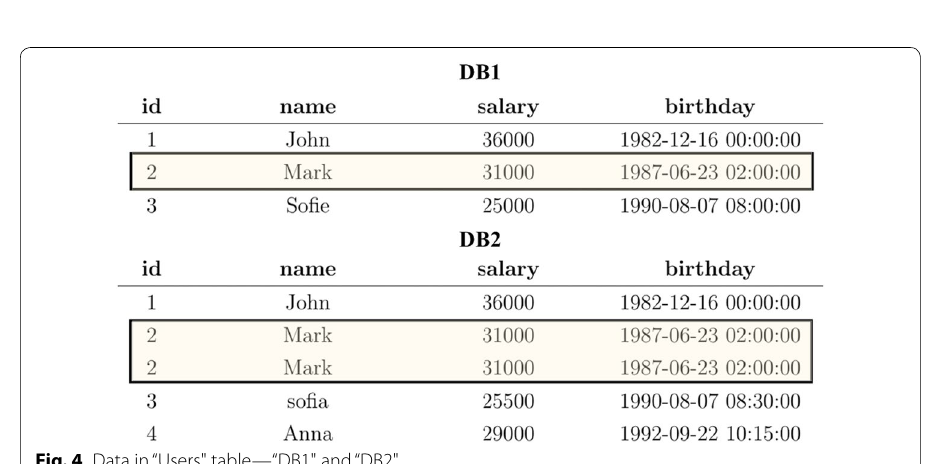
Fig. 4 Data in “Users" table—“DB1" and “DB2"